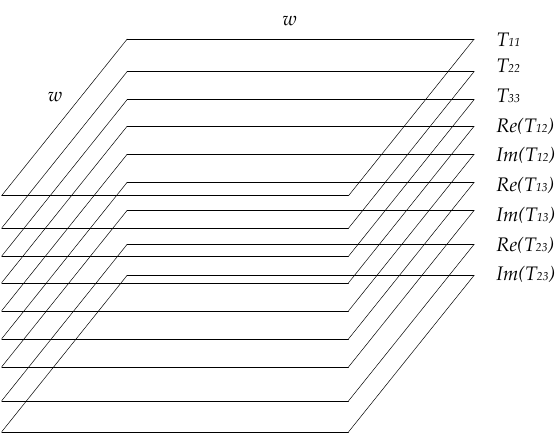
Figure 5. Input matrix of